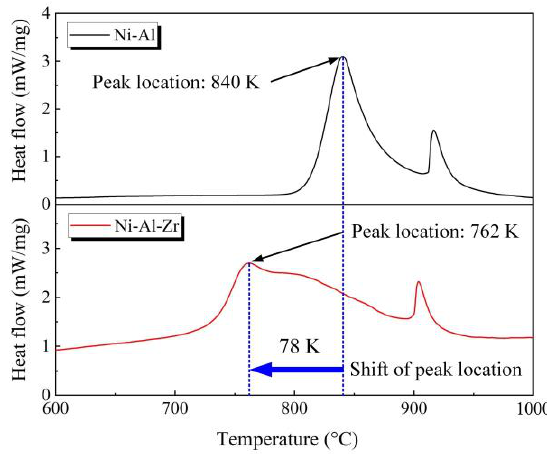
Figure 5. DSC curves of the interlayers.